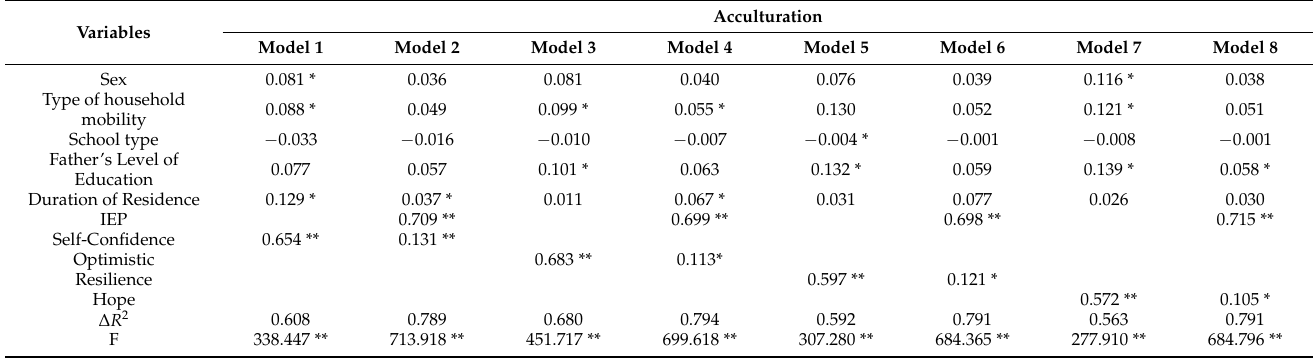
Table 4. Moderating effect of PC on the relationship between IEP and